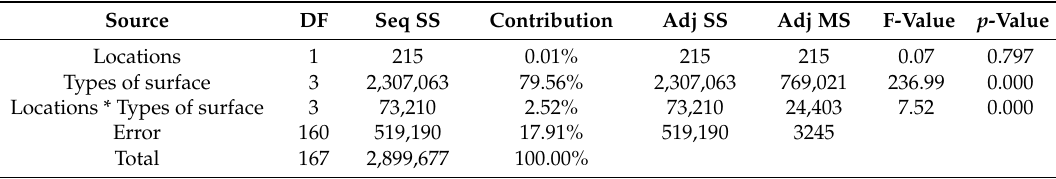
Table 4. Two-way ANOVA results.